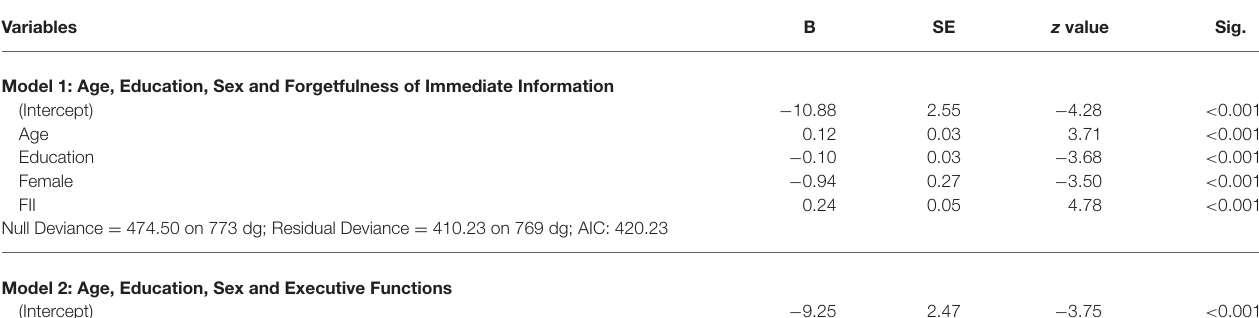
TABLE 5 | Logistic regression models for diagnostic by EMQ-10’s factors and total score. Variables B SE z value